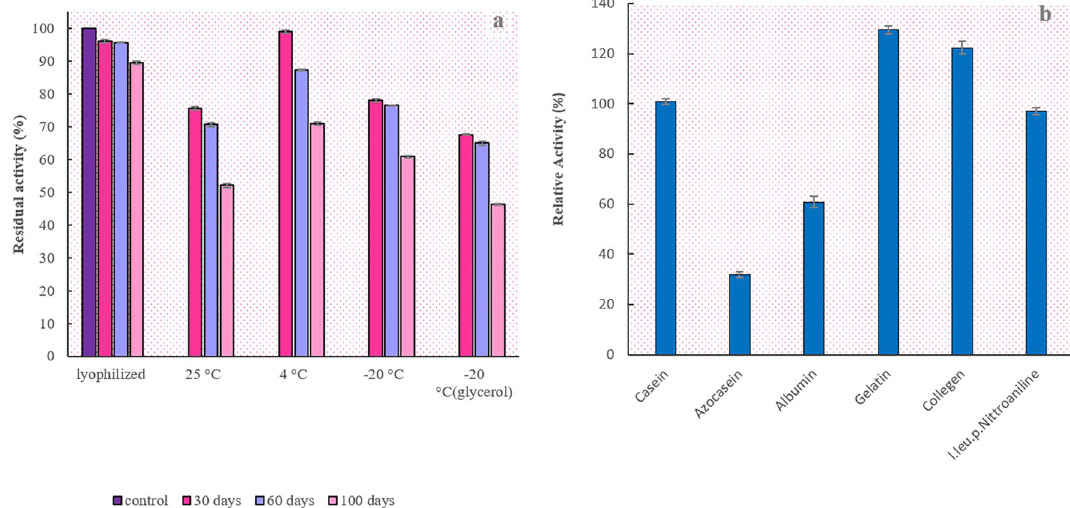
Figure 10. ( a ) Relative activity of the enzyme during 100 days of storage. rEla showed remarkable stability and the enzyme half-life at room temperature was about 100 days which makes it an excellent candidate for different industrial applications ( b ) rEla substrates specificity. The enzyme activity in presence of gelatin and collagen was 130% and 120% respectively.